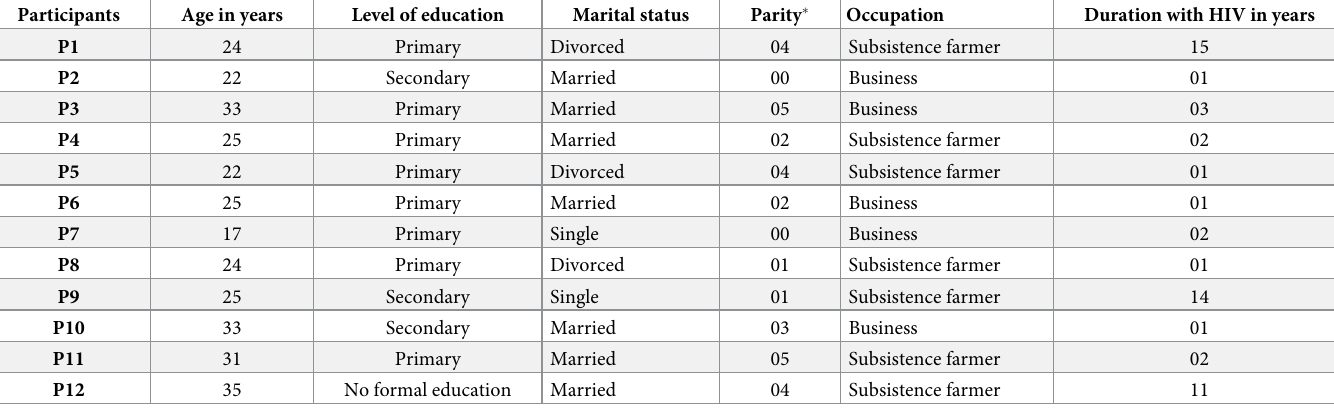
Table 1. Description of the study